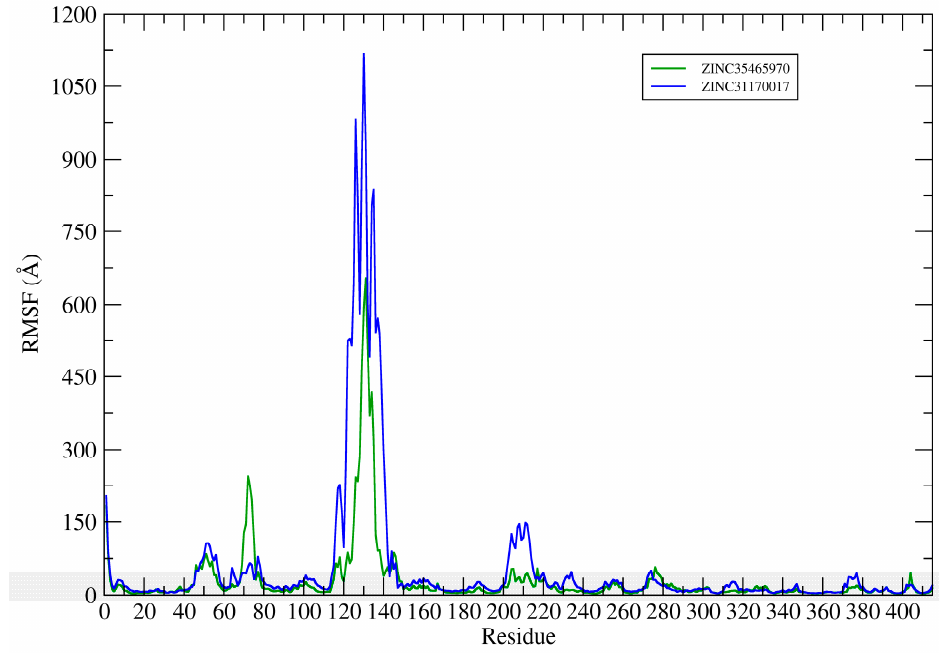
Figure 9. Protein backbone RMSF plots.